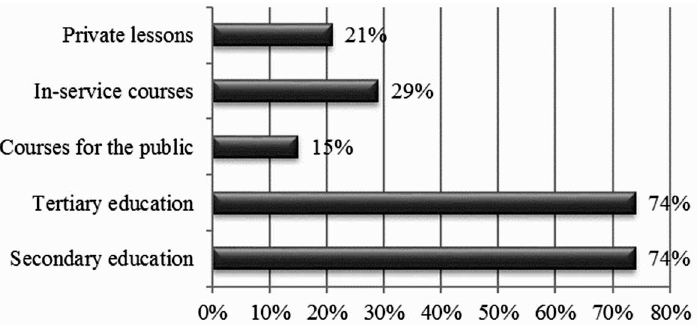
Figure 2. Experience in learning